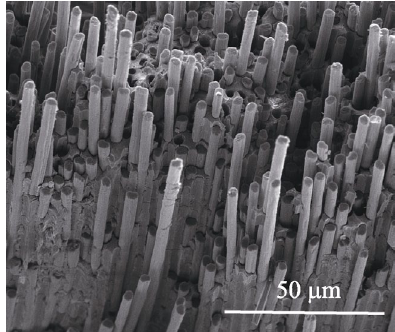
Fig. 4 SEM photo of fracture surface of the C/mullite composites without interfacial